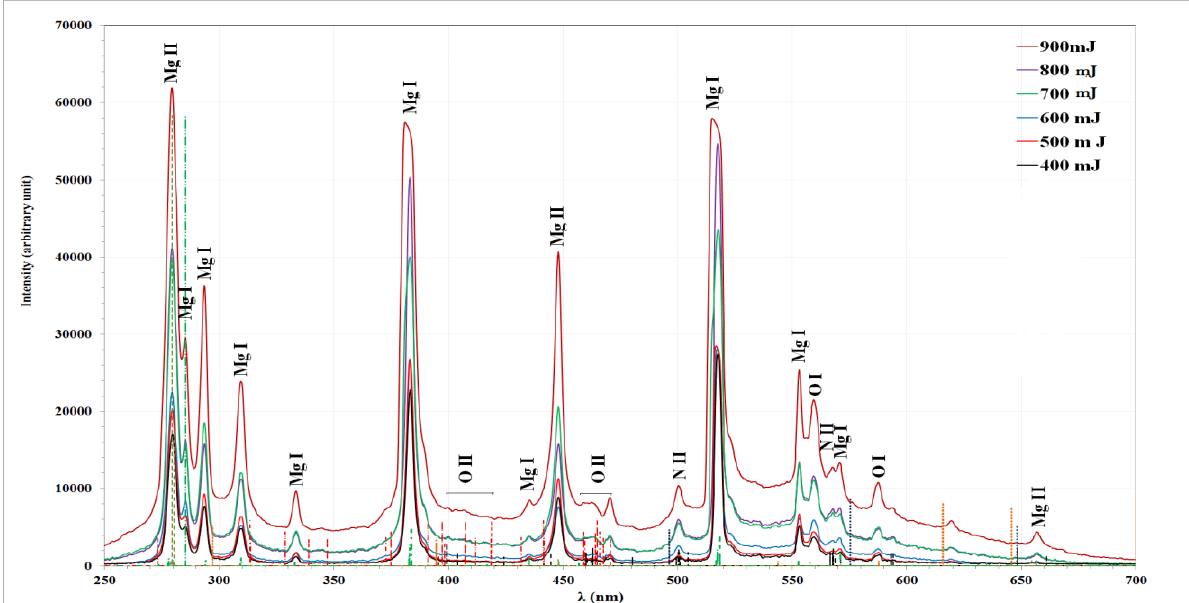
Fig.3: Plasma emission spectra induced by 1064 nm laser, with different laser energies for magnesium powder in